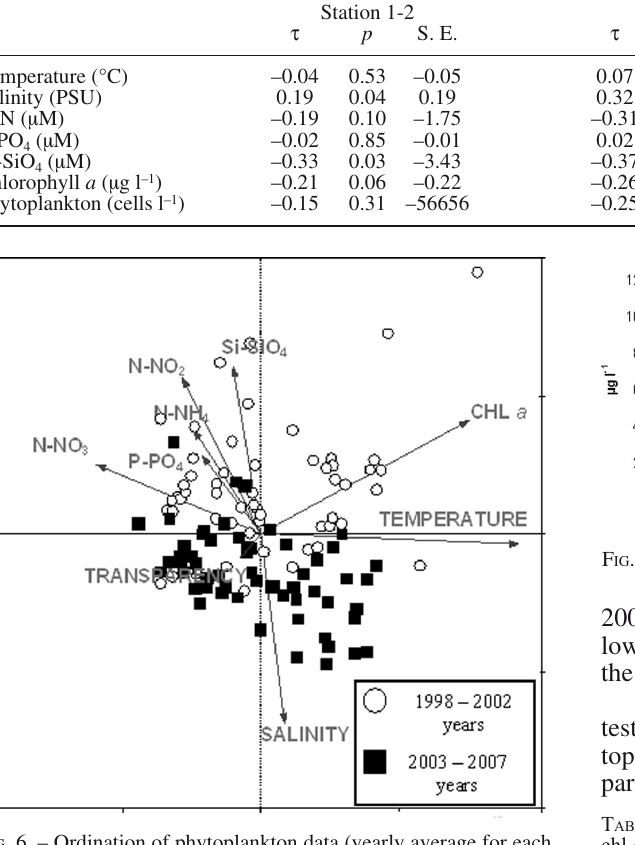
f ig . 6. – Ordination of phytoplankton data (yearly average for each station), showing differences between the periods 1998-2002 (open circles) and 2003-2007 (full